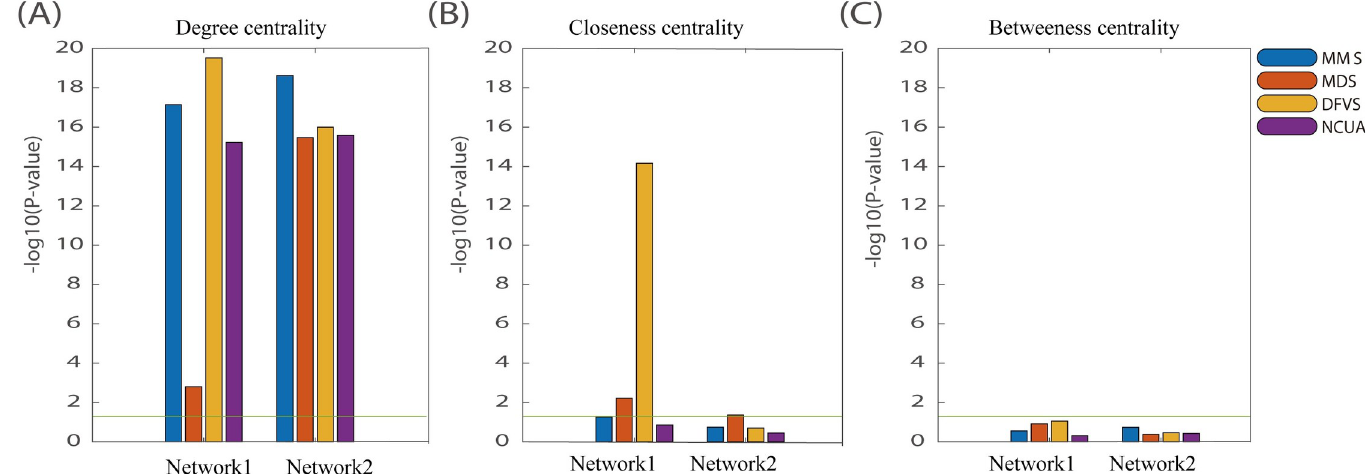
Fig 11. The P -value results of these network structure factors compared with random selection method. (A) Degree centrality; (B) Closeness centrality; (C) Betweeness centrality.